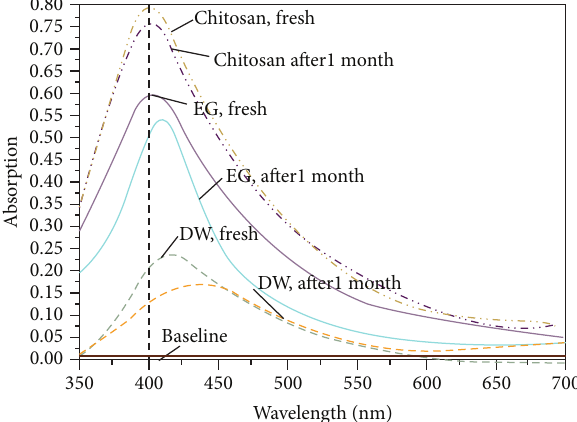
Figure 7: UV-visible absorption spectra of Ag-NPs in EG, DW, and chitosan for freshly prepared and after 1